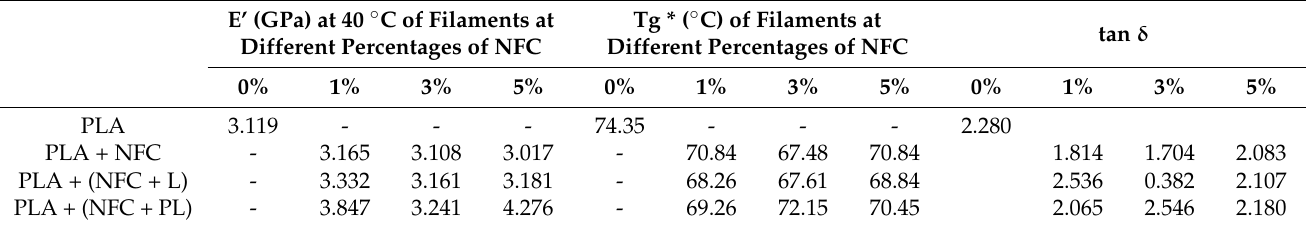
Table 7. Bending storage modulus E’ at 40 ◦ C and glass transition temperature Tg of filaments. E’ (GPa) at 40 ◦ C of Filaments